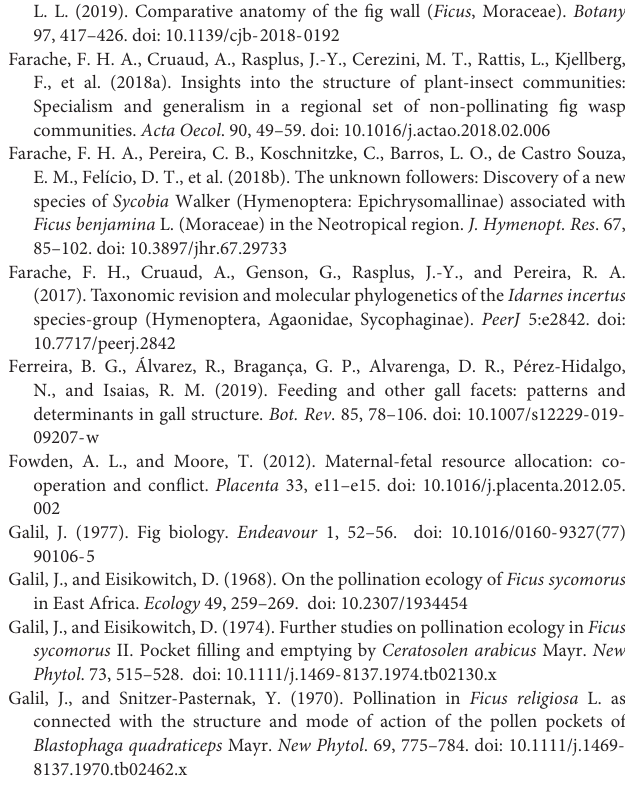
fig wasp community structured by gall size. Insect Conserv. Diver . 11, 341–351. doi: